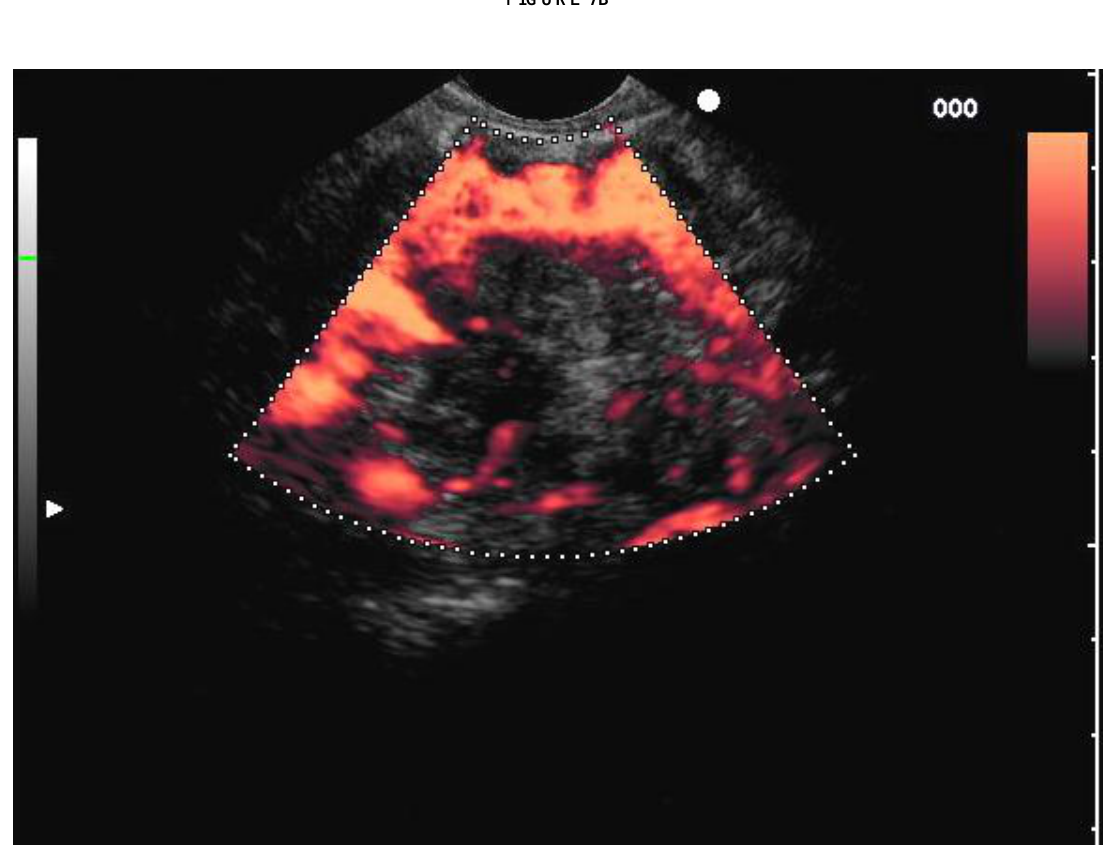
FIGURE 8 . Pancreatic adenocarcinoma; no enhancement of vascularization after sonovue